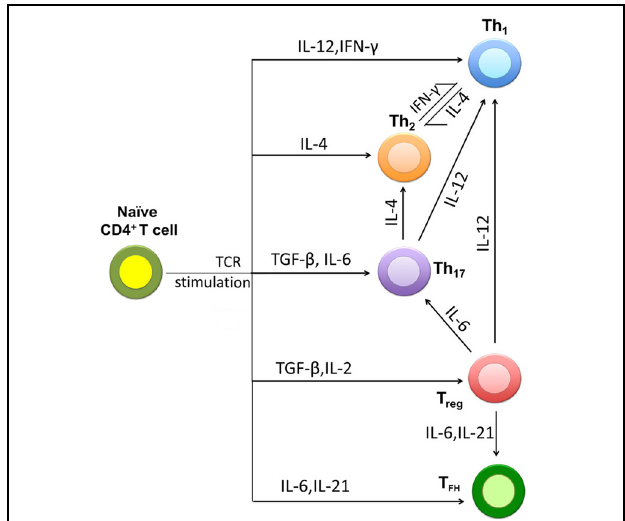
FIGURE 1 | Major pathways of naïve CD4 + T cell differentiation into effectors. Upon encountering the antigens presented by the professional antigen-presenting cells (APCs) naïve CD4 + T cells differentiate into Th1, Th2, or Th17 effector cells. Cytokines present in the environment during differentiation play the major role in determining the phenotype that the CD4 + T cell will acquire. Two other CD4 + T cell subsets include regulatory T cells (Treg) and T follicular helper cells (Tfh). Due to cellular plasticity differentiated effector CD4 + T cells may convert from one type into another. For example, Th17 cells under strong polarizing conditions (e.g., high concentrations of IL-12) may convert into Th1 cells.